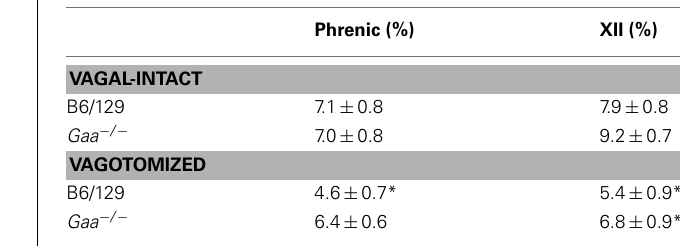
Table 2 | The coefficient of variation of phrenic and XII nerve amplitude in B6/129 and Gaa − / −